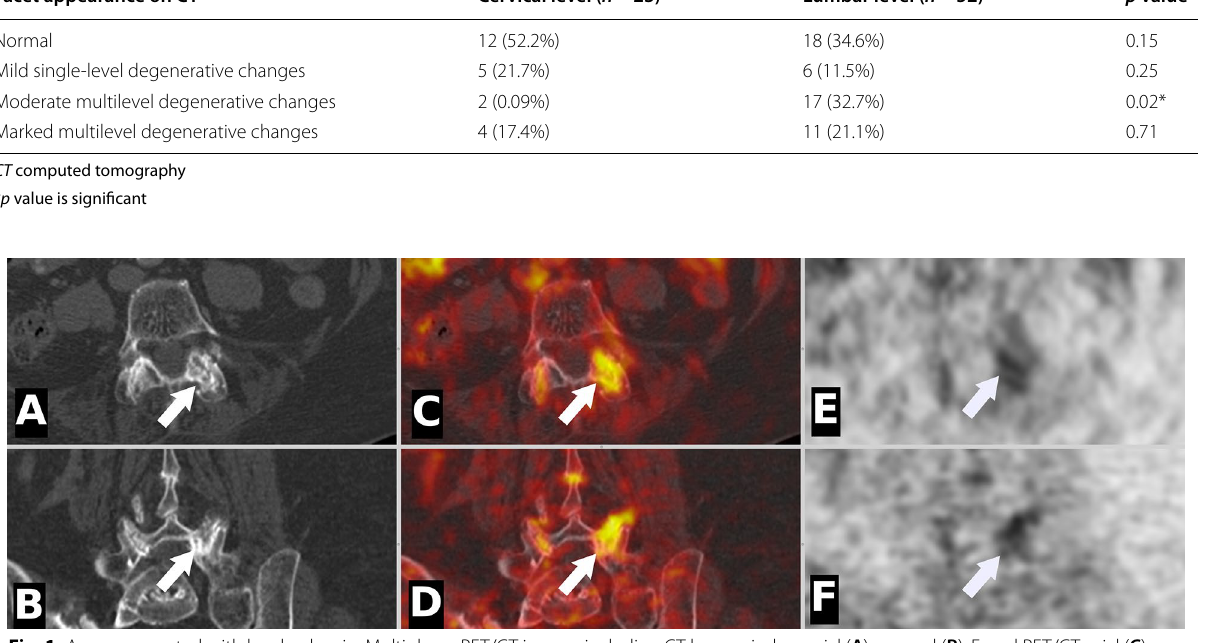
Fig. 1 A case presented with low back pain. Multiplanar PET/CT images including CT bone window axial ( A ), coronal ( B ). Fused PET/CT axial ( C ), coronal ( D ), PET axial ( E ), coronal ( F ). Increased 18F-FDG uptake (arrows) related to bilateral L4/L5 facet joints, more on the left, with underlying degenerative changes on the corresponding CT images